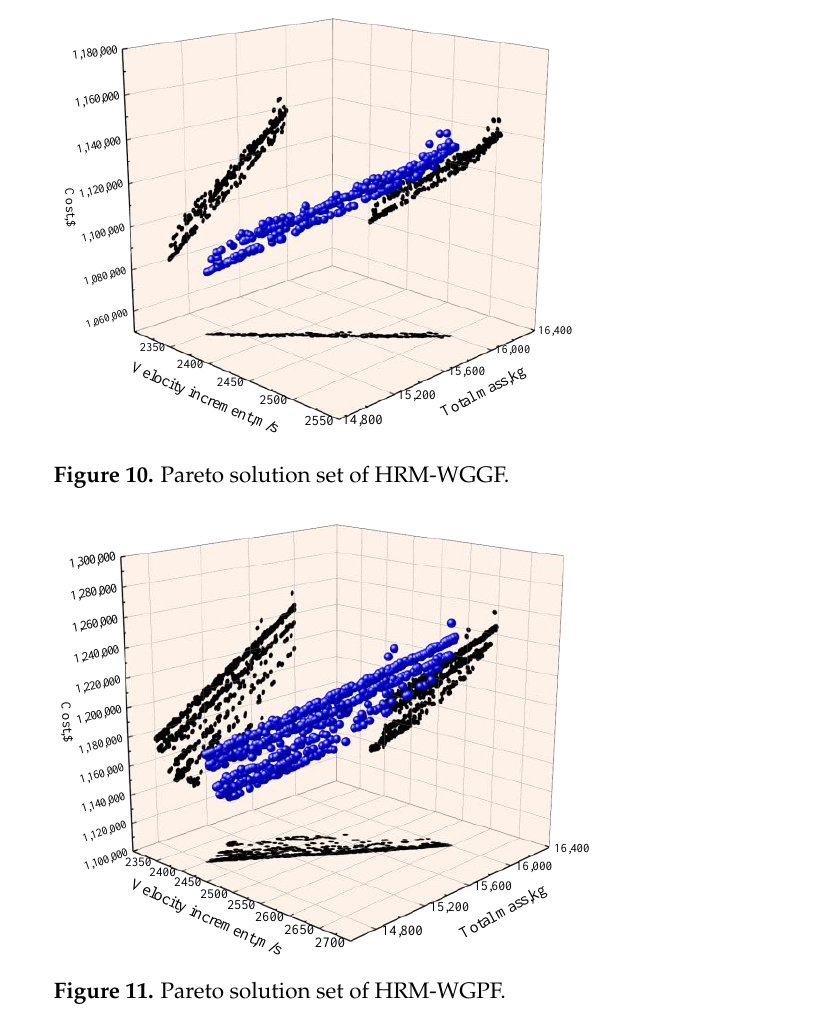
Figure 9. Pareto solution set of HRM-TGPF.